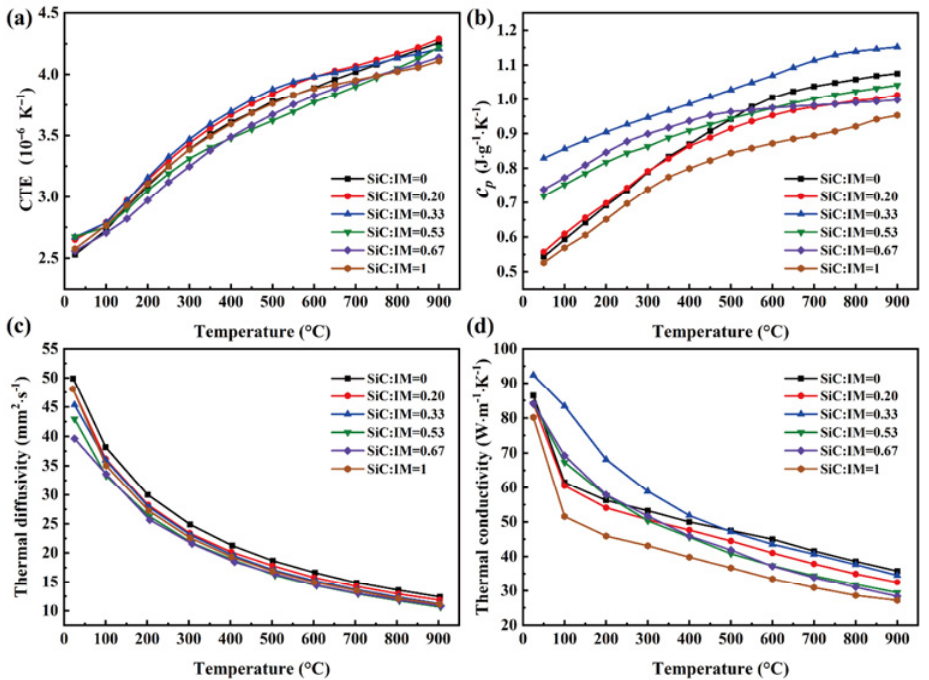
Fig. 14 Thermal properties of SiC composites: (a) α ; (b) c p ; (c) a ; and (d) κ